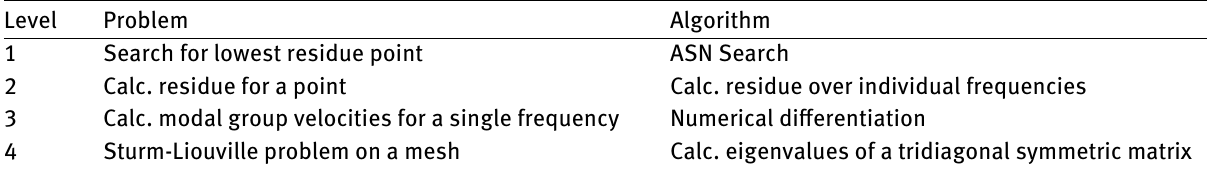
Table 2: Hierarchy of algorithms used in the process of solving the geoacoustic inversion problem.